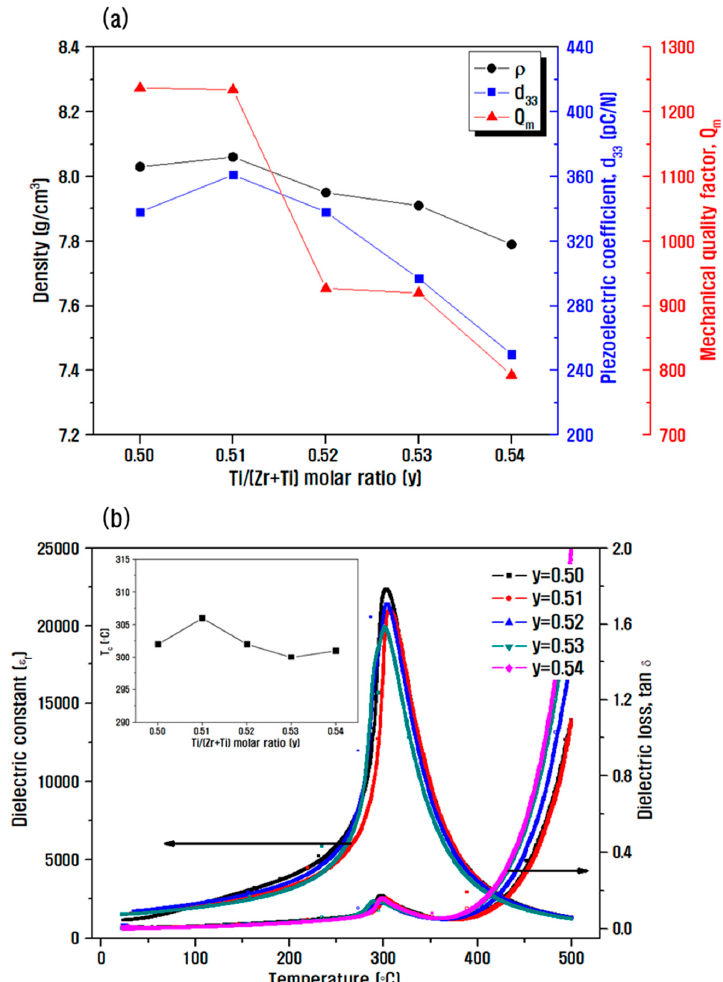
Figure 7. ( a ) Change in density and electrical properties represented by d 33 and Q m , ( b ) dielectric properties with respect to temperature change at 1 kHz measurement (inset graph: Curie temper- ature change) according to the Zr/Ti ratio change in the basic composition of 0.14PZN-0.06PMN- 0.80PbZ 1 − y T y and composition added with 0.1 wt.% Sb 2 O 3 .